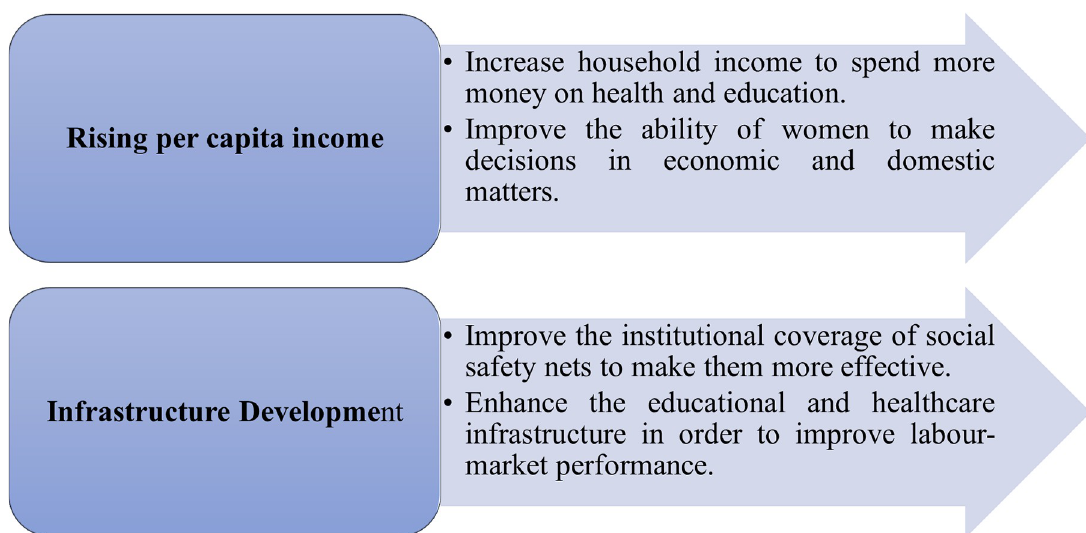
Fig 3. Wealth function. Source: Adapted from Mujeed et al. [33] and authors extract.